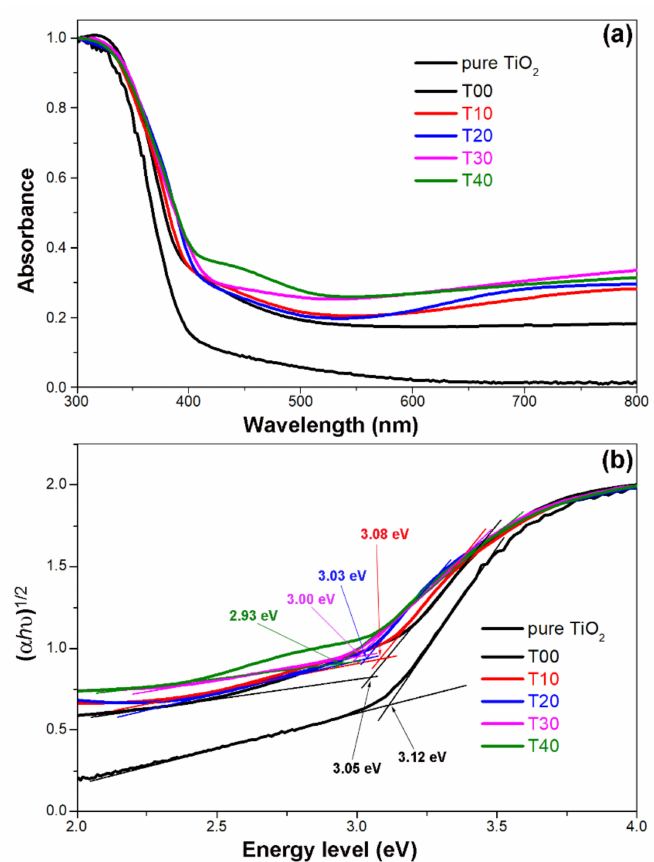
Figure 5. ( a ) UV-vis diffuse reflectance spectrum of TiO 2 photocatalysts; ( b ) Plotting curves of Kubelka–Munk against photon energy over pure TiO 2 , T00, T10, T20, T30 and T40,